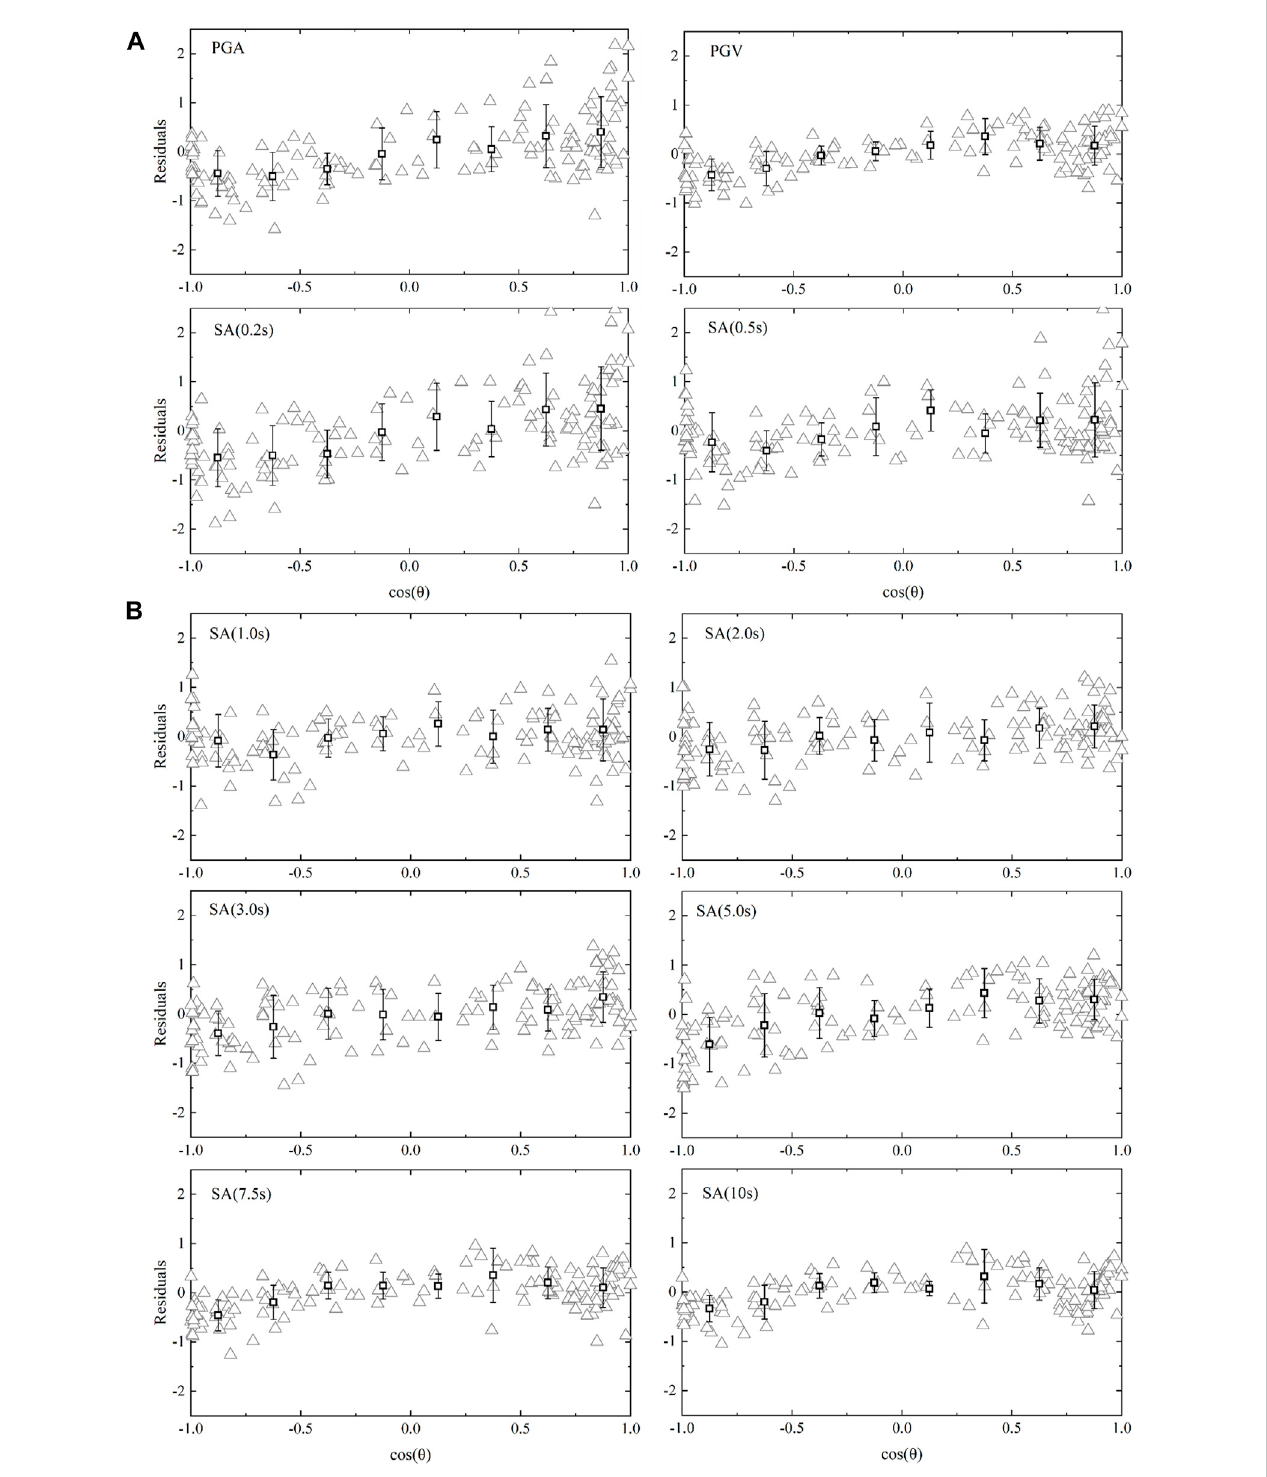
FIGURE 7 Variationsinresidualswithparameter θ forvariousIMs (A) PGA,PVG,andshort-periodgroundmotionsoflessthan1.0 s; (B) long-periodgroundmotions of greater than 1.0 s. The vertical bars represent the mean and standard deviation for the binned